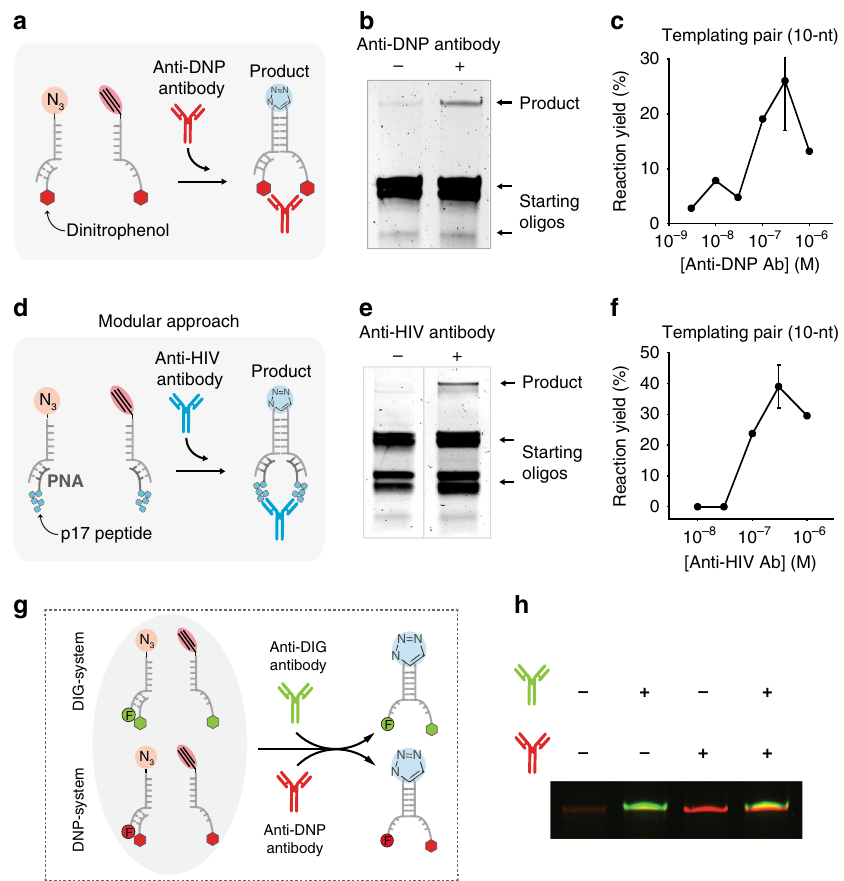
Fig. 4 Orthogonal control of reactions mediated by different speci fi c antibodies. a Scheme of the CuAAC reaction triggered by an anti-DNP antibody. The templating pairs were modi fi ed with azide and alkyne reactive groups and with DNP. b Denaturing PAGE of CuAAC reactions in the absence and presence of anti-DNP antibody for the 10-nt complementary domain. c Reaction yield determined by densitometric analysis of PAGE bands at different concentrations of anti-DNP antibody (10-nt templating pair). d Scheme of the modular approach used to achieve CuAAC reaction triggered by an anti-HIV antibody. The templating pairs were modi fi ed with azide and alkyne reactive groups. The templating pairs were both hybridized to strands conjugated at one end with a p17 peptide recognized by an anti-HIV antibody. e Denaturing PAGE of CuAAC reactions in the absence and presence of anti-HIV antibody for the 10-nt complementary domain. f Reaction yield determined by densitometric analysis of PAGE bands at different concentrations of anti-HIV antibody (10-nt templating pair). g Two systems with templating pairs each labeled with a speci fi c recognition element (DIG and DNP) were used in the same solution. One strand from each templating pair was also labeled with a different fl uorophore to differentiate the products. h Denaturing PAGE of CuAAC reactions in the absence and presence of the two speci fi c antibodies. Templated CuAAC reactions in this fi gure were all performed at 37 °C for 2 h at a 100 nM concentration of templating strands and 300 nM of the speci fi c antibody in presence of Cu(l) catalyst in 25 mM HEPES buffer pH 7.2, 0.1 M NaCl. The experimental values represent averages of two separate measurements and the error bars re fl ect the standard deviations. Source data are provided as a Source Data fi